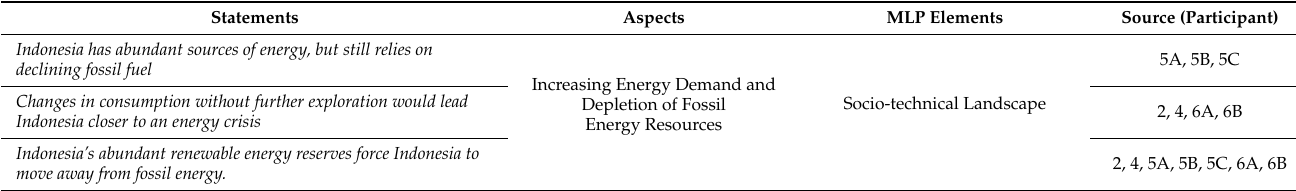
Table A1. Summary of the